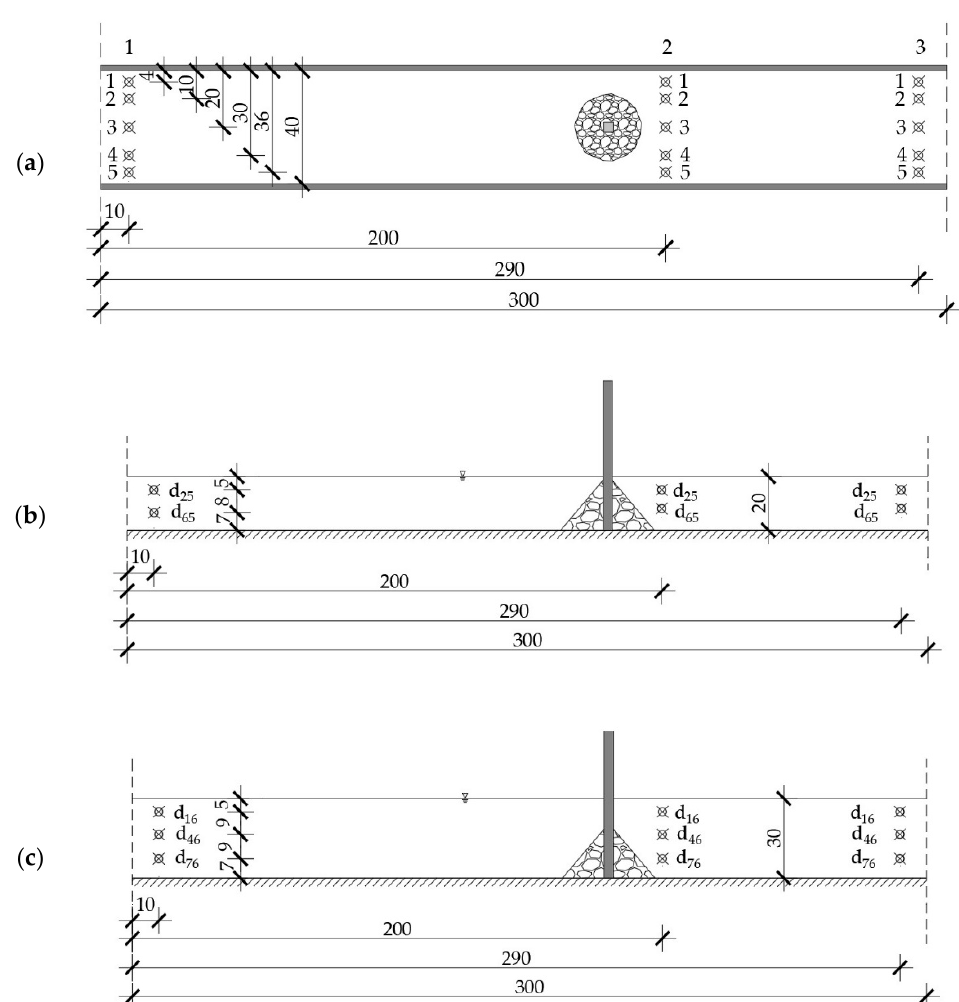
Figure 4. Flume working section with measurement points: layout ( a ) and longitudinal profiles for a smaller flow depth ( b ) and larger flow depth ( c ), all lengths are given in centimeters.